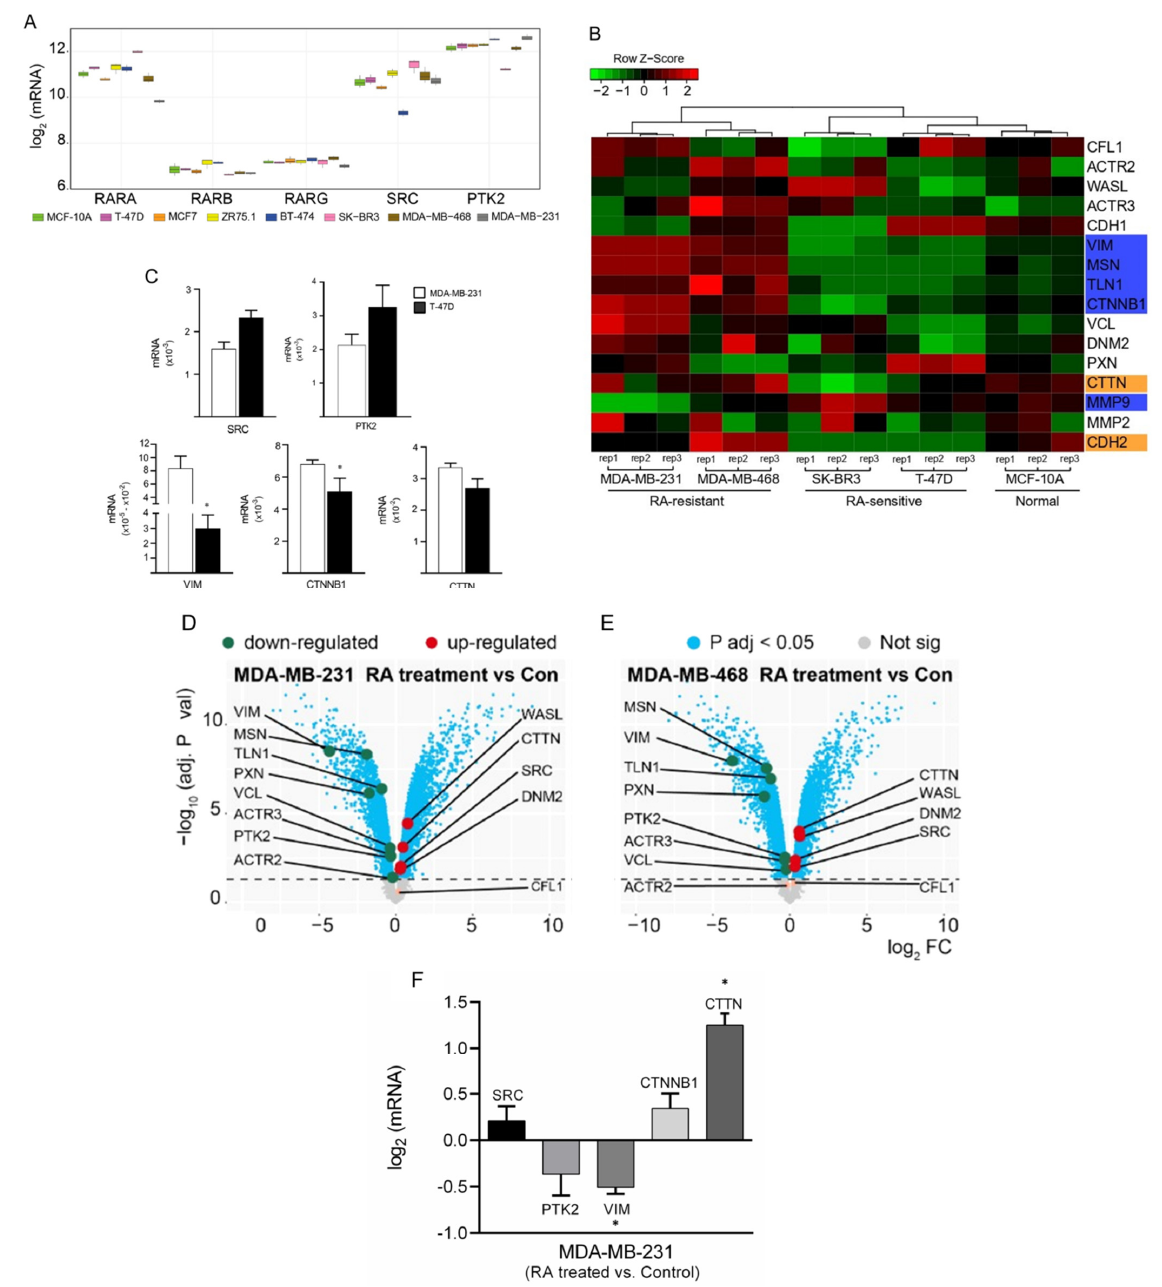
Figure 1. Expression of genes involved in metastasis process in a panel of BC cells. ( A ) Boxplot showing the gene expression patterns of five genes of interest: RARA, RARB, RARG, SRC, and PTK2 (encoding RAR α , RAR β , RAR γ , Src, and FAK respectively). Each color represents a breast cell line (MCF-10A, MCF-7, T-47D, ZR75.1, BT-474, SK-BR3, MDA-MB-468, MDA-MB-231). ( B ) Gene expres- sion heatmap of 16 genes involved in different processes related to metastasis. The MCF-10A, T- 47D, SK-BR3, MDA-MB-468, and MDA-MB-231 cell lines were used. Expression patterns of genes are represented in a green-red scale where low expression levels are in green and high expression